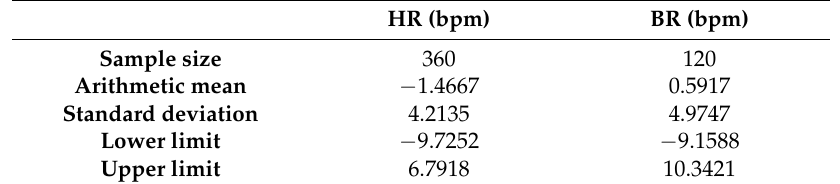
Figure 6. Bland-Altman plot showing the level of agreement between ( a ) HR monitor and HR with the camera, ( b ) BR monitor and BR with the camera. Dispersion diagram showing the relationship between the measurements made with the contact method and the proposed method ( c ) HR monitor and HR with the camera, ( d ) BR monitor and BR with the camera. Table 2. Information on the differences found in the measurements by the Bland-Altman method.